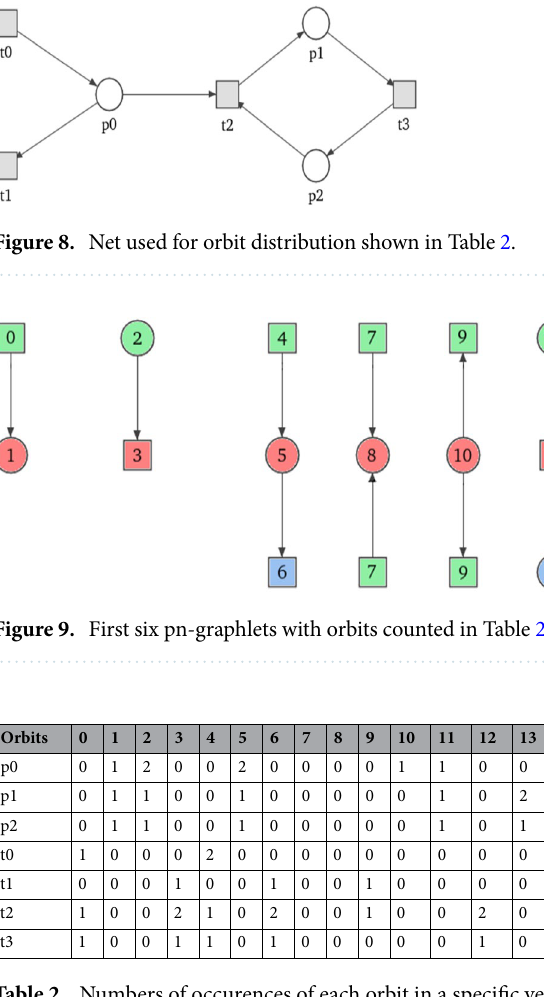
Table 2. Numbers of occurences of each orbit in a specific vertex in the exemplary Petri net shown in Fig. 8.